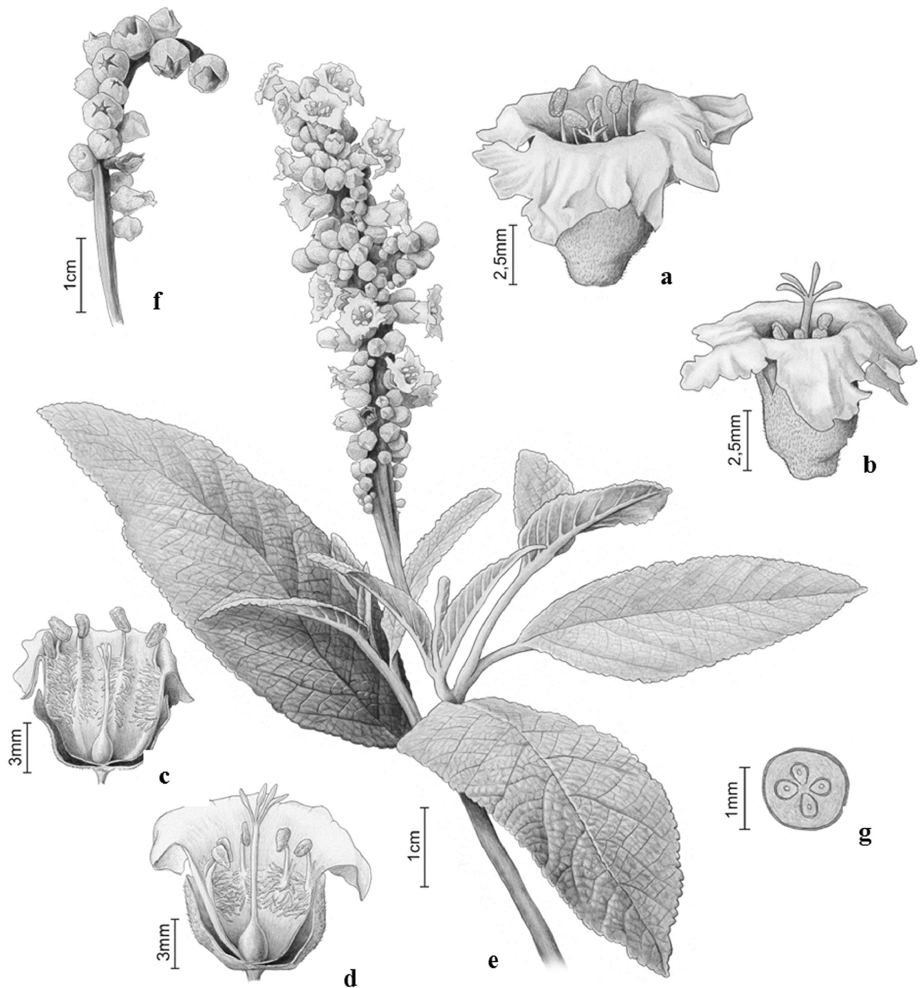
Figure 1 - a-g. Varronia curassavica Jacq. - a. Brevistylous flower; b. longistylous flower; c. brevistylous flower lateral section showing the reproductive structures; d. longistylous flower lateral section showing the reproductive structures; e. branch with inflorescence; f. infructescence; g. gynoecium. Illustration: Leandro Lopes de